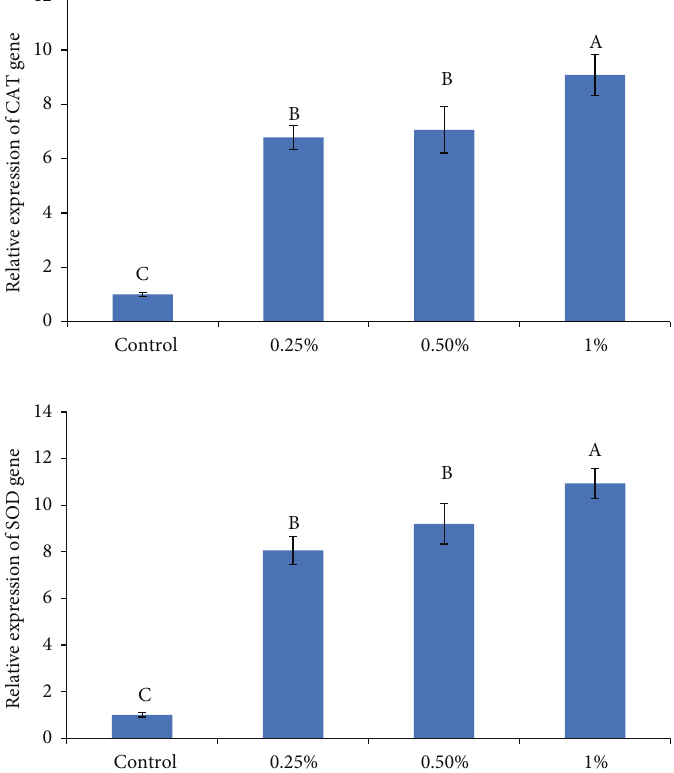
Figure 2: The e ff ects of di ff erent levels of U. intestinalis on antioxidant enzyme gene expression in the intestine of zebra fi sh. Values are presented as the mean ± S : D . The bars assigned with di ff erent letter denote signi fi cant di ff erence between treatments ( P < 0 : 05